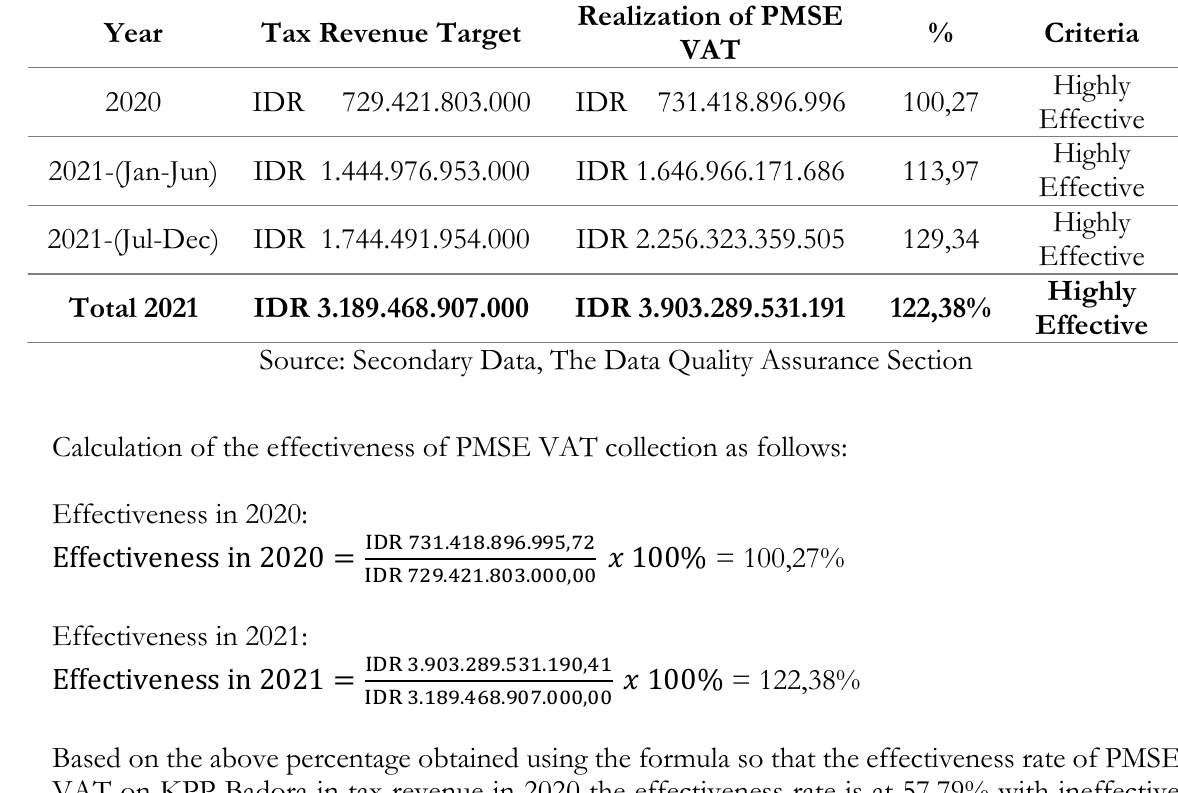
Realization of PMSE VAT on KPP Badora in 2020 and